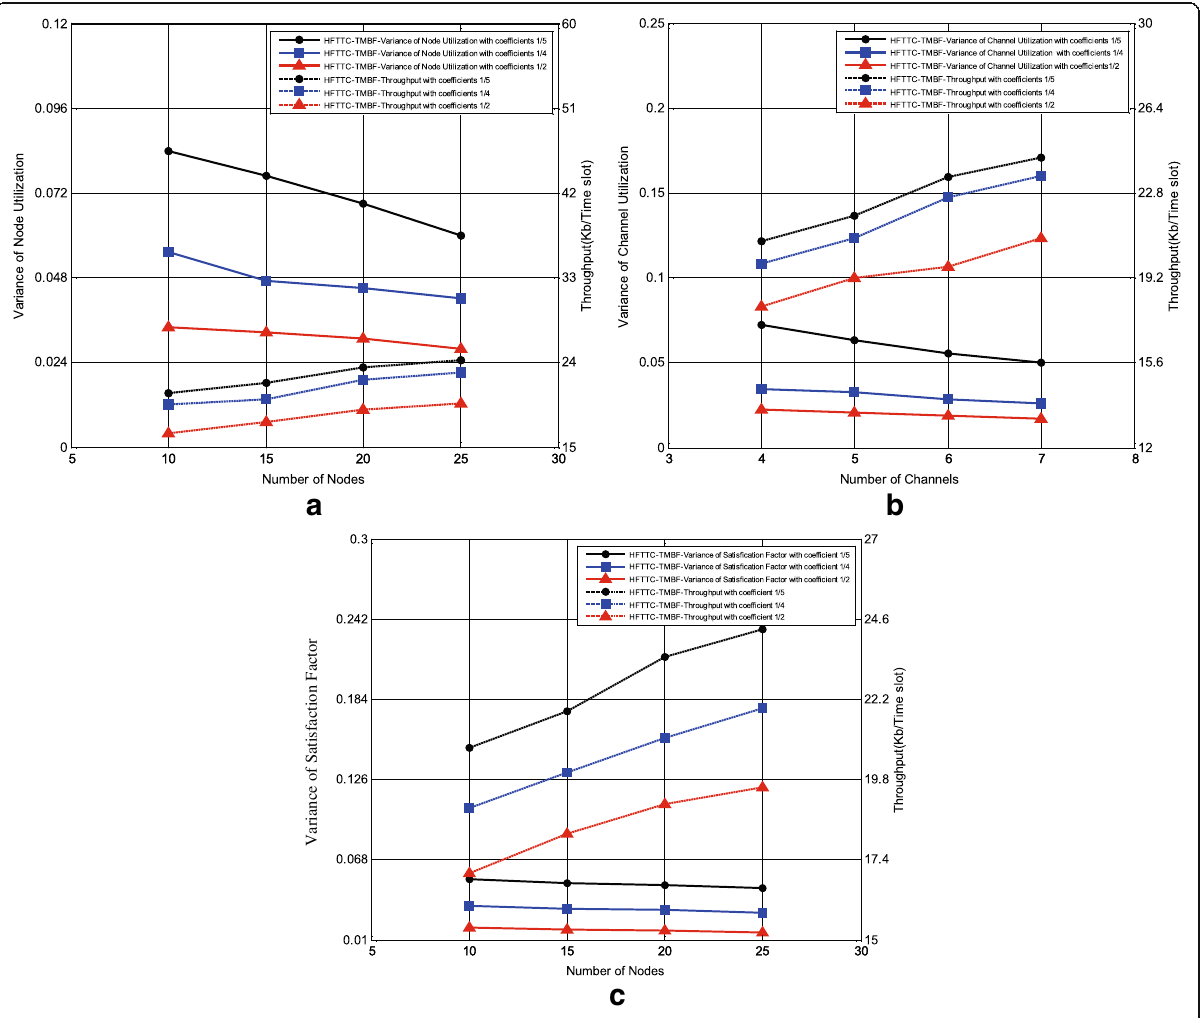
Fig. 7 Analysis of the impact of the fairness and balancing factors on the throughput in HFTTC-TMBF ( a ) impact of the node utilization balancing factor ( b ) impact of the channel utilization balancing factor ( c ) impact of the fairness